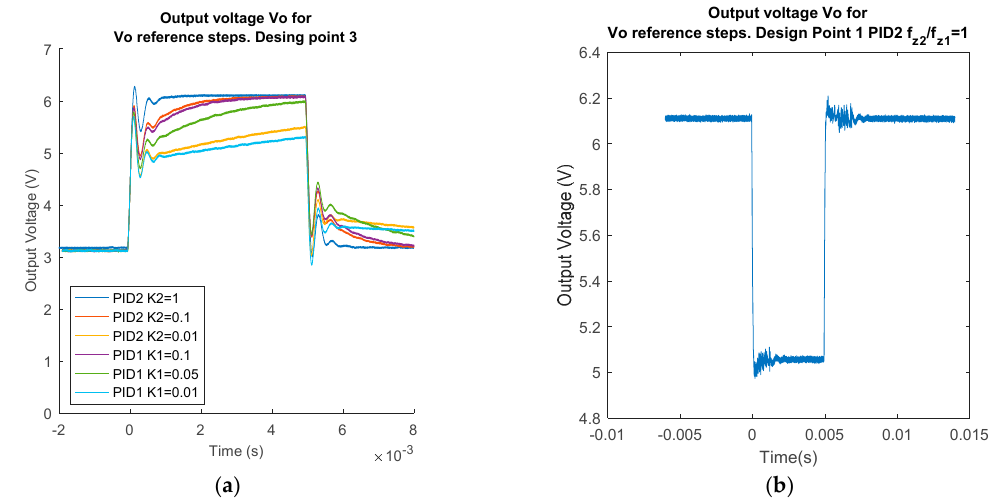
Figure 15. Experimental time-domain waveforms when there is a step in the voltage reference. ( a ) Step response for different designs with f c = 2817 Hz, PM = 43° (Design point 3); ( b ) step response for design-point 1, using 9 bits in the ADC (note that there is no limit cycling).